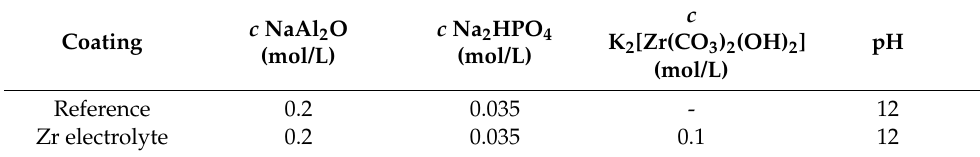
Table 1. Composition and pH of the electrolytic solutions used for the production of PEO coatings.